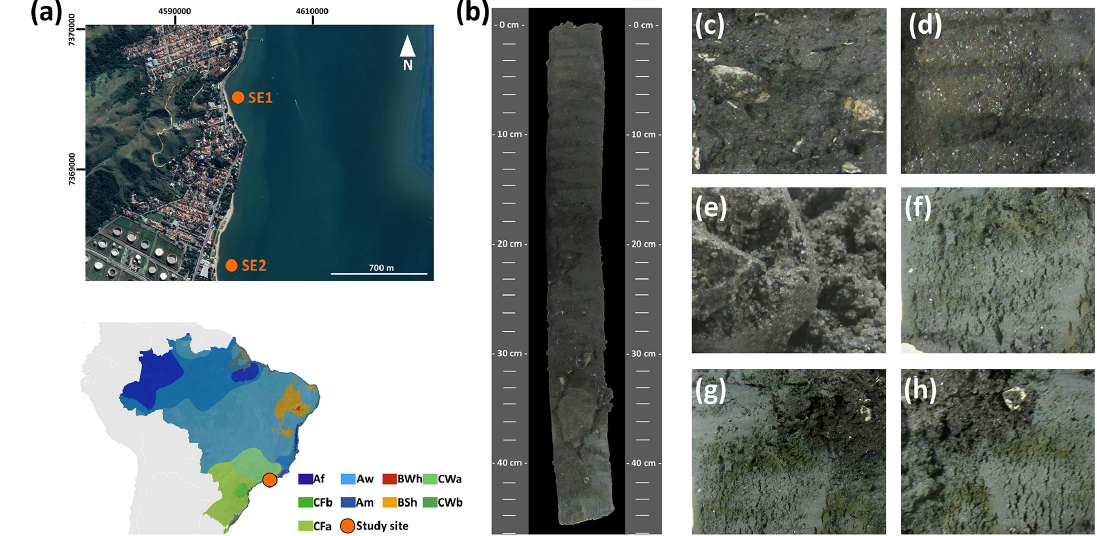
Figure 2. (a) Sampling site location on the southeastern Brazilian coast and the Köppen–Geiger climatic classification of the studied sites (source: Peel et al., 2007). (b) The representative soil profile of the southeastern coast (SE2, soil horizons: Arz 0–5cm, ACrz 5–12cm, Crz 12–26cm, Crnz 26–33cm, 2Crzn1 33–42cm, 2Crz2 42–47cm, 2Crz3 47–50 + cm) classified as a Eutric Fluvic Reductigleyic Subaquatic Gleysol (Loamic, Hypersalic, Sodic, Hyposulfidic). Detailed images of (c) fragmented seashells in the 2Crz1 soil horizon, (d) mica-like grain morphology in the surface horizons of the soil profile (feature produced by sediment inputs from the surrounding crystalline rocks), (e) coarse soil texture (loamy coarse sand) in the ACrz horizon, (f) finer soil texture (coarse sandy loam) in the 2Crz3 horizon, and (g) and (h) very dark greenish gray colors (10BG 3/1) in the Crnz soil